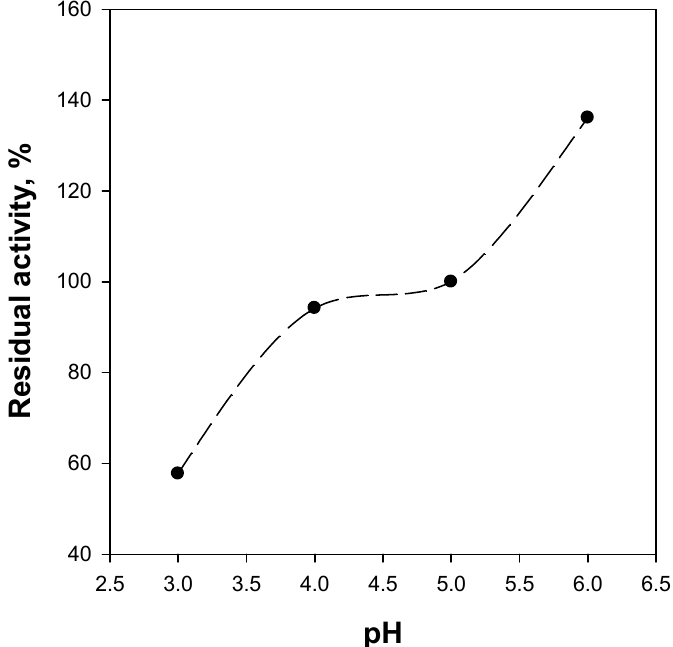
Figure 7. Residual activity of WSN monolith catalysts as a function of pH. Batch-equivalent contact ◦ time: 1 h; temperature: 50 °C. time: 1 h; temperature: 50